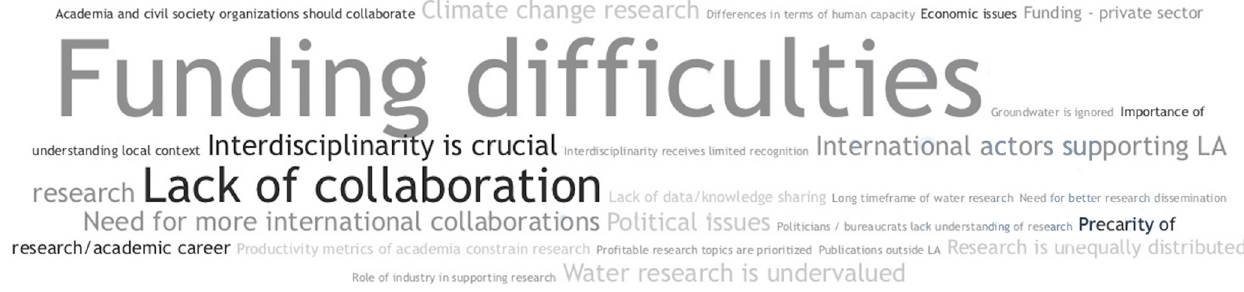
Figure 4. Word cloud based on word frequency from survey